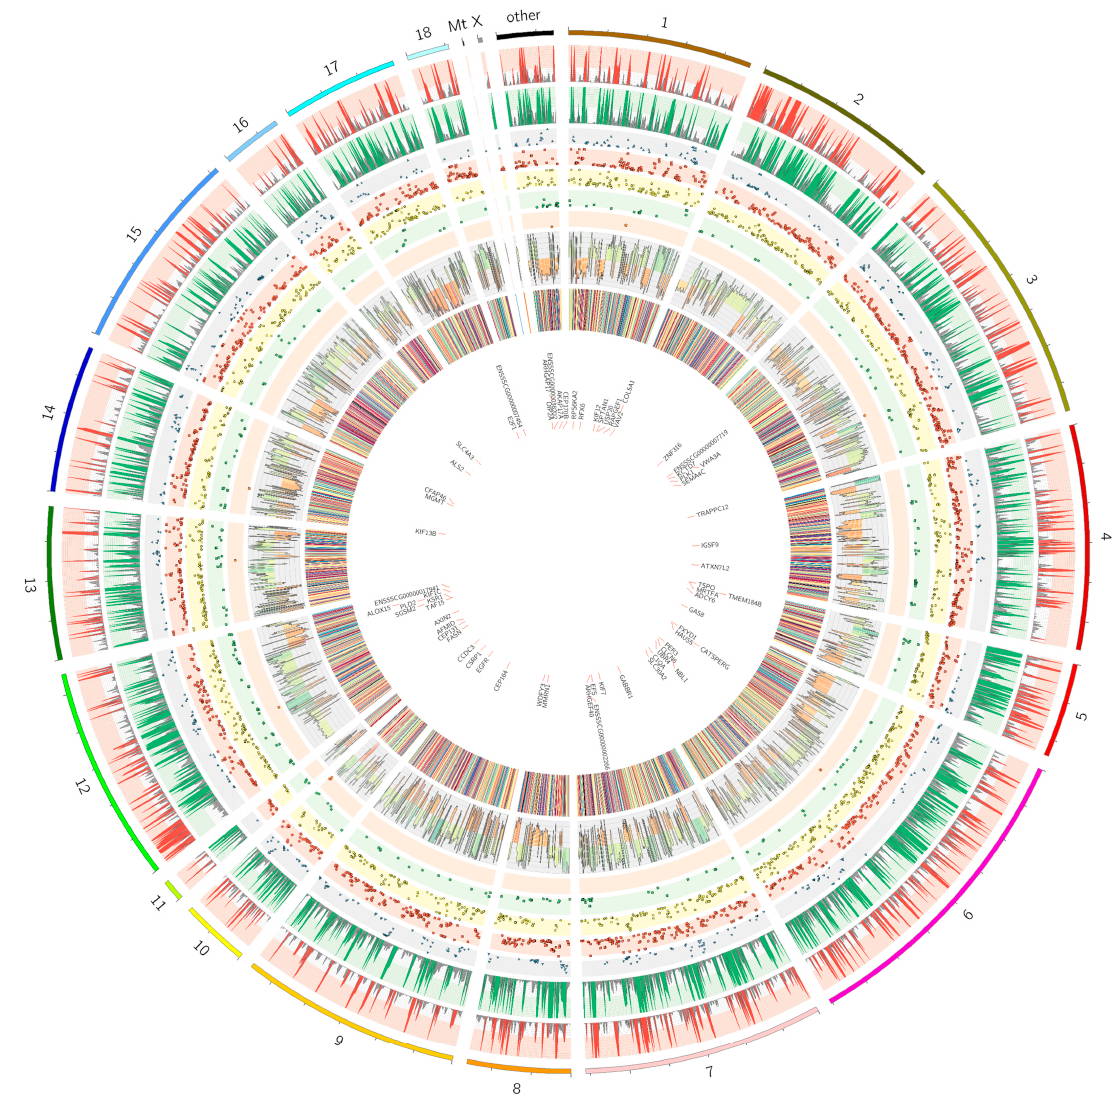
Figure 6. Visualization of the allele-specific expression (ASE) sites exposed to the low dose of LPS. The external circle represents the porcine chromosomes and scaffolds, where each chromosome length describes the number of ASEs. Two upper tracks depict the coverage of the reference (red histogram) and alternative variants (green histogram) in all the RNA-seq libraries. The next five middle scatter plots show the localization of ASE on intergenic (blue triangles), UTR (red squares), CDS (yellow dots), intron (green squares on green background) and ncRNA region (orange squares on orange background); vertical axis on each scatter plot shows the normalized FDR. The histogram visualizes a difference in the alternative allele fraction ( Δ AAF) between the LPS-treated samples and the controls. In this track, green indicates a higher AAF in the controls and orange represents a higher AAF in the LPS samples. The tenth track (12-color barcode plot) presents an abundance of 12 types of nucleotide substitutions. The most inner track depicts the names of 55 DEGs with significant Δ AAF in ASFE sites.